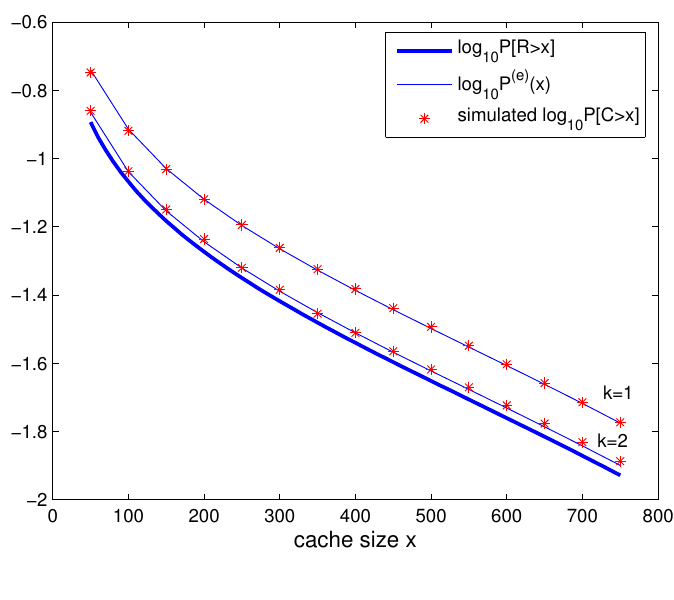
Fig. 1: Illustration for Experiment